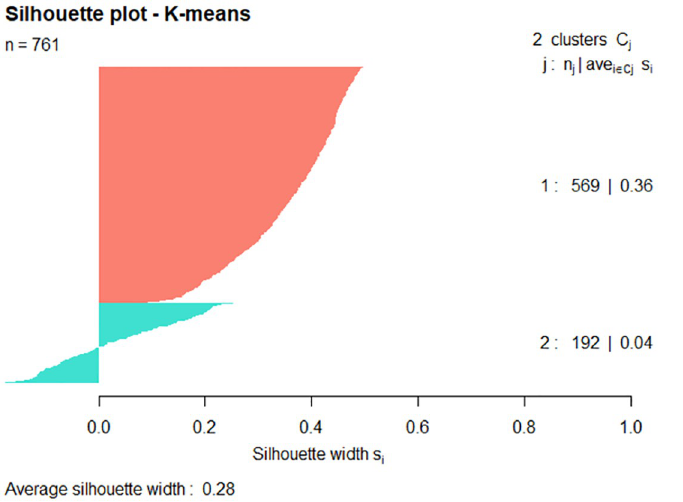
Fig 9. Silhouette plot of Straw-necked Ibis where k =